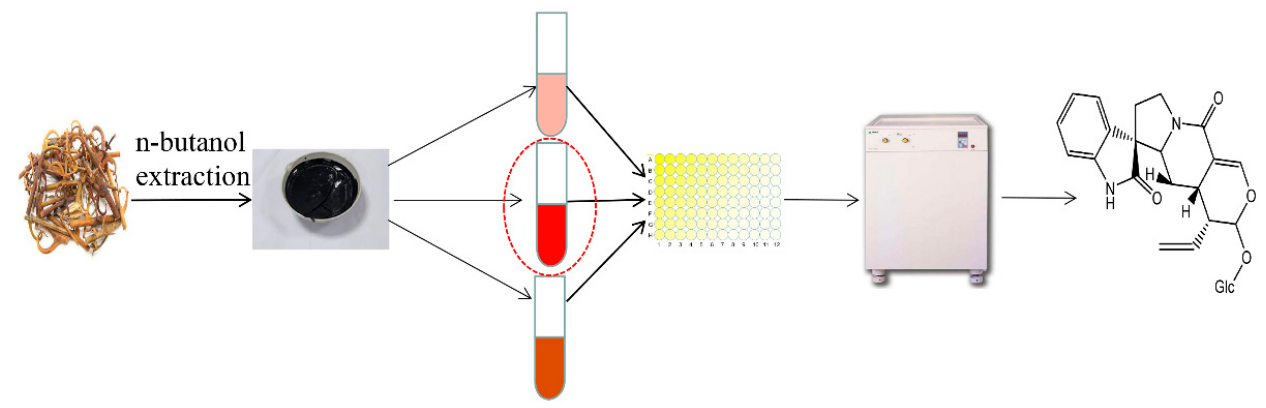
Figure 1. The effective method for targeted isolation of alkaloids with cholinesterase inhibitory activity from UR using HSCCC.